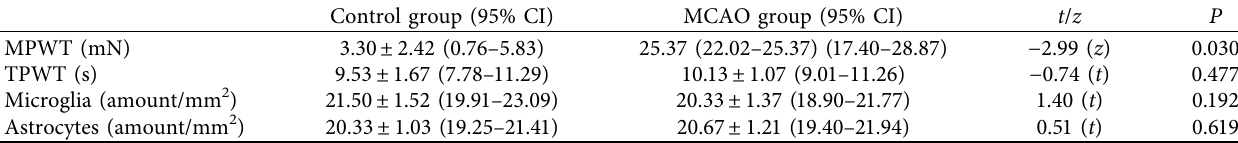
Table 1: Changes in pain-related behavioral testing and number of glial cells in the control and middle cerebral artery occlusion groups.